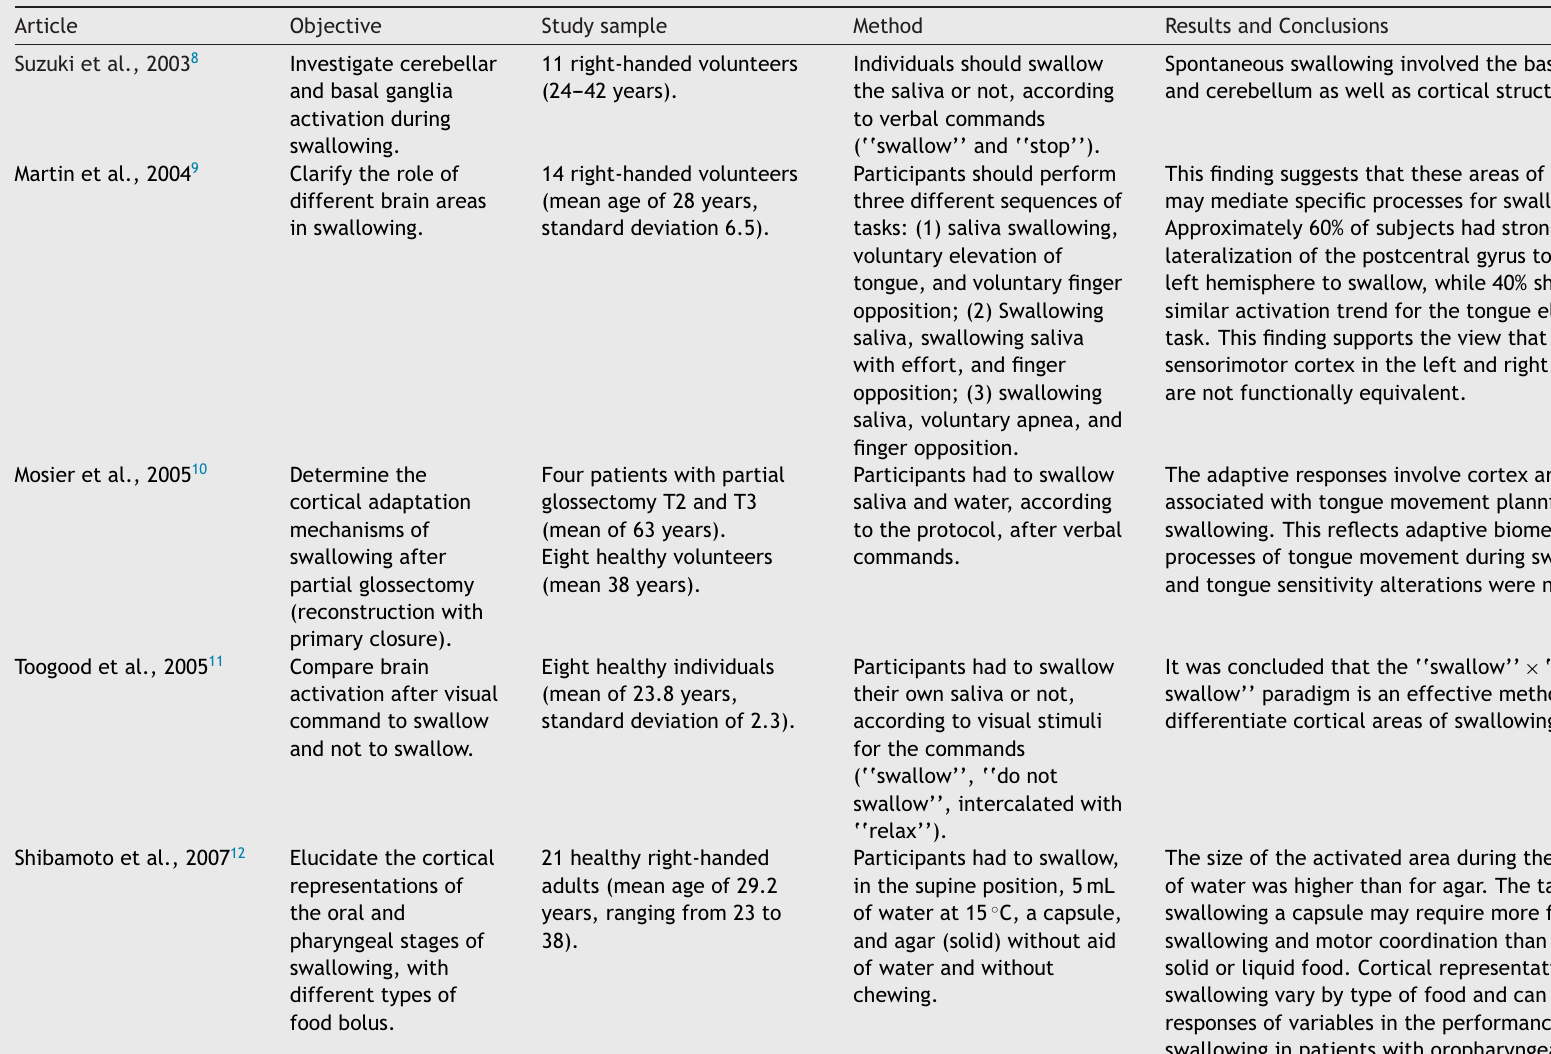
Summary of the articles used in this